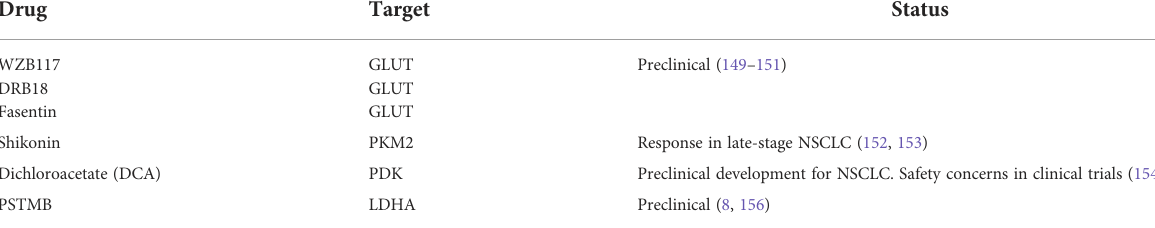
TABLE 2 Inhibitors of metabolic enzymes in preclinical/clinical development for NSCLC. Drug